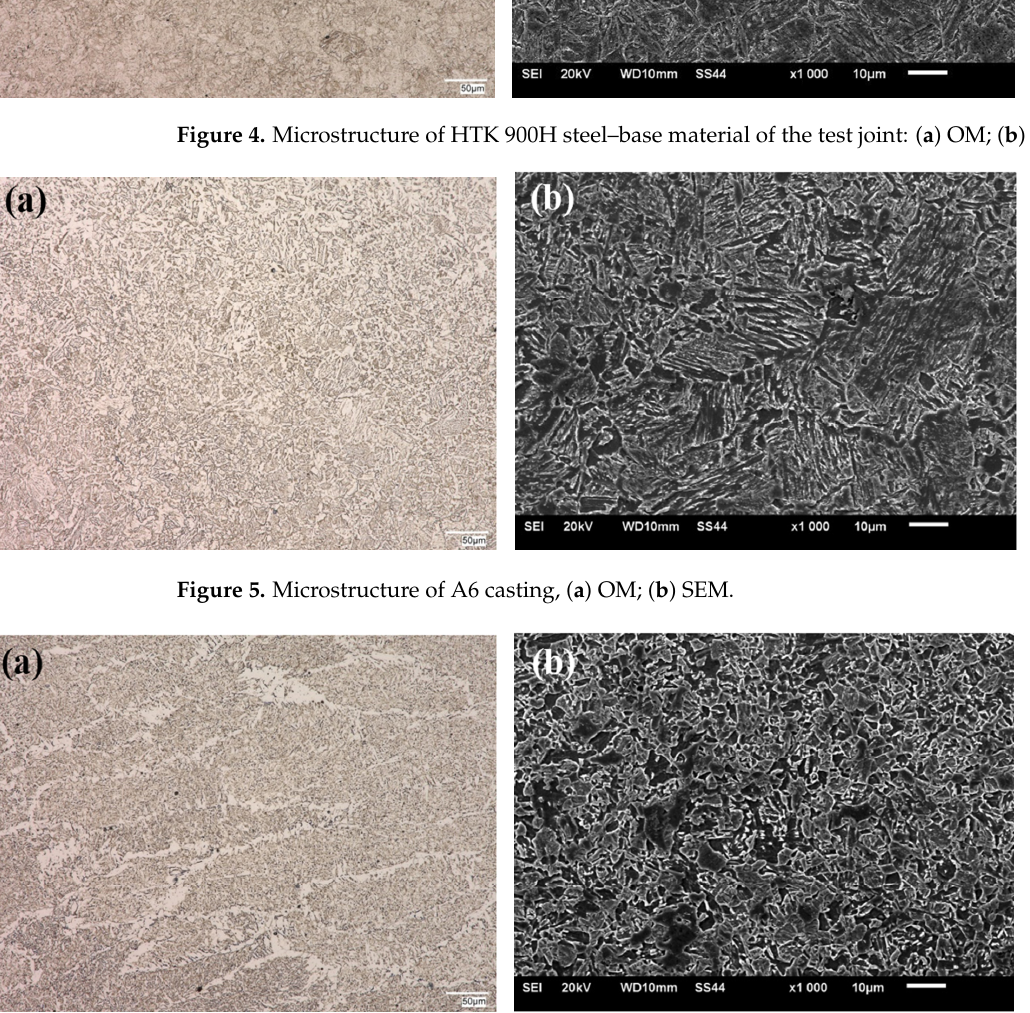
Figure 7. Microstructure of HAZ in A6 casting, ( a ) OM; ( b ) SEM.